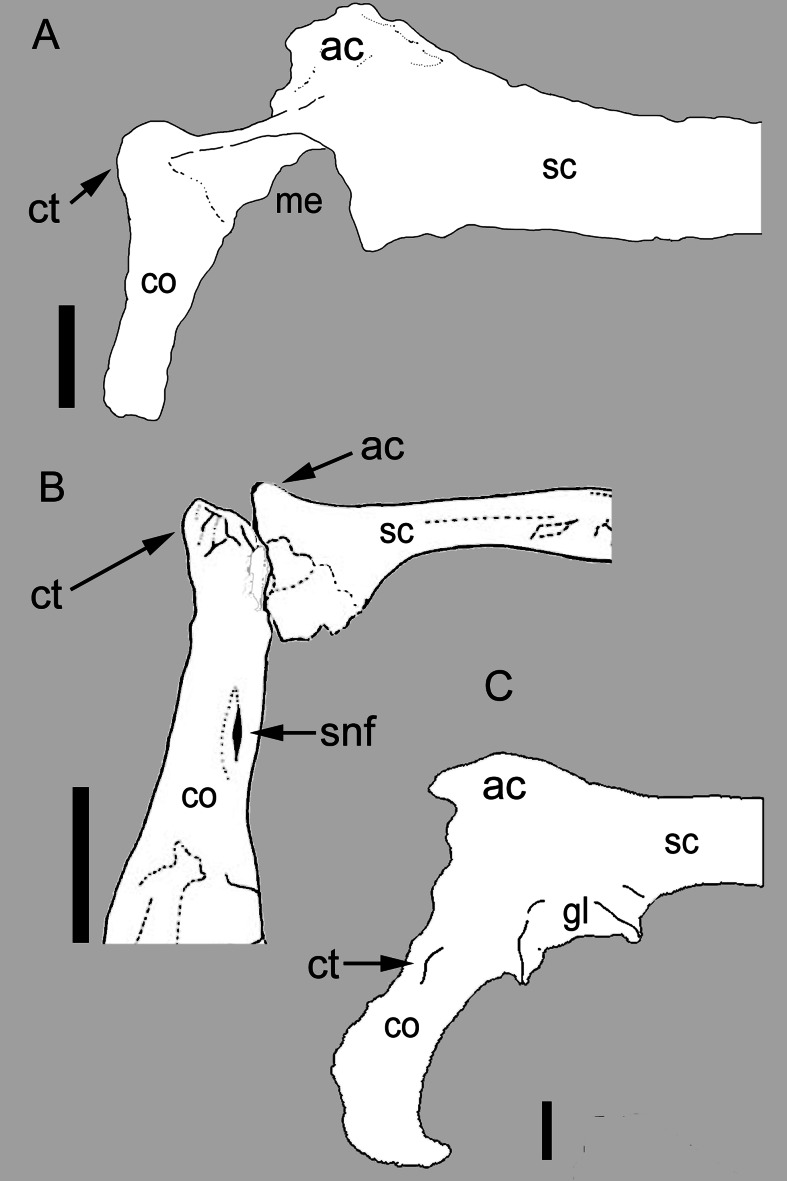
Comparison between the scapulocoracoid of Balaur and other paravians.Comparison of the scapulocoracoid of (A) Balaur (lateral view) to that of (B) the pygostylian Enantiophoenix (medial view); and (C) the dromaeosaurid Velociraptor (lateral view); (A) after Csiki et al.. (2010, Fig. 1); (B) modified after Cau & Arduini (2008, Fig. 2); (C) after Norell & Makovicky (1999, Fig. 4). All scapulocoracoids are drawn with the proximal half of the scapular blade oriented horizontally to show relative placement of coracoid tubercle. Scale bar: 10 mm (A); 5 mm (B); 10 mm (C). Abbreviations: ac, acromion; co, coracoid; ct, coracoid tubercle; gl, glenoid; me, missing element; sc, scapula; snf, supracoracoid nerve foramen.